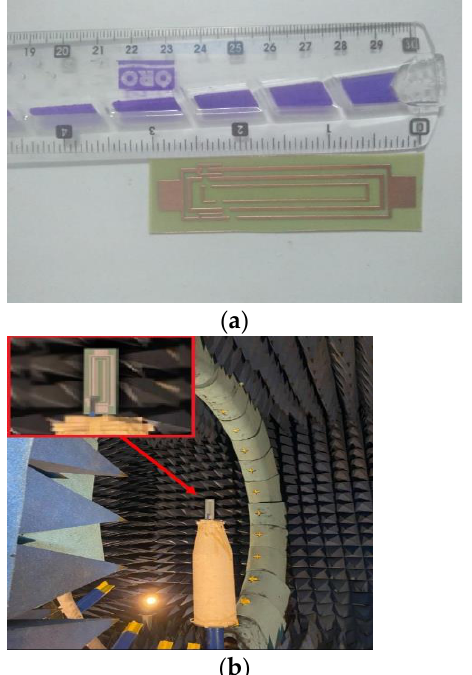
Figure 16. Experimental results. ( a ) Fabricated Antenna. ( b ) Proposed UHF antenna tested inside the anechoic chamber.